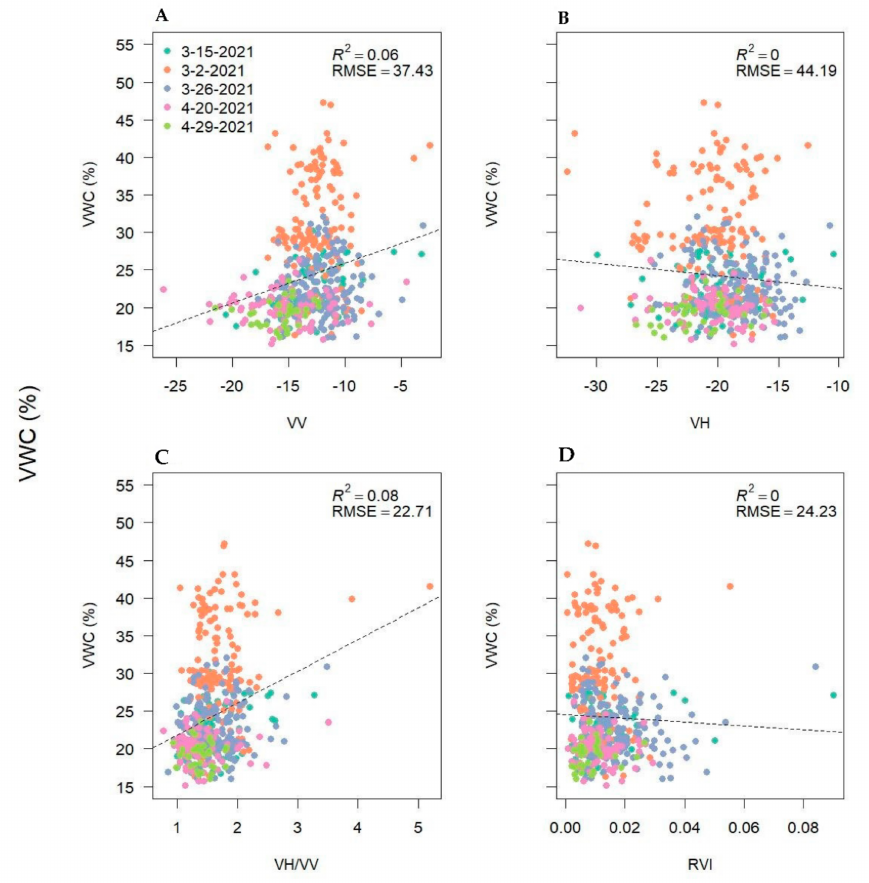
Figure A1. Volumetric water content (VWC) as a function of synthetic aperture radar linear backscat- ter intensities—vertical-vertical (VV; ( A )), vertical horizontal (VH, ( B )), VV/VH ratio ( C ) and the radar vegetation index (RVI; ( D ))—from five handheld soil moisture data collections in March and April adjacent to plot locations and across the seven study fields. VWC collections were timed with Sentinel-1